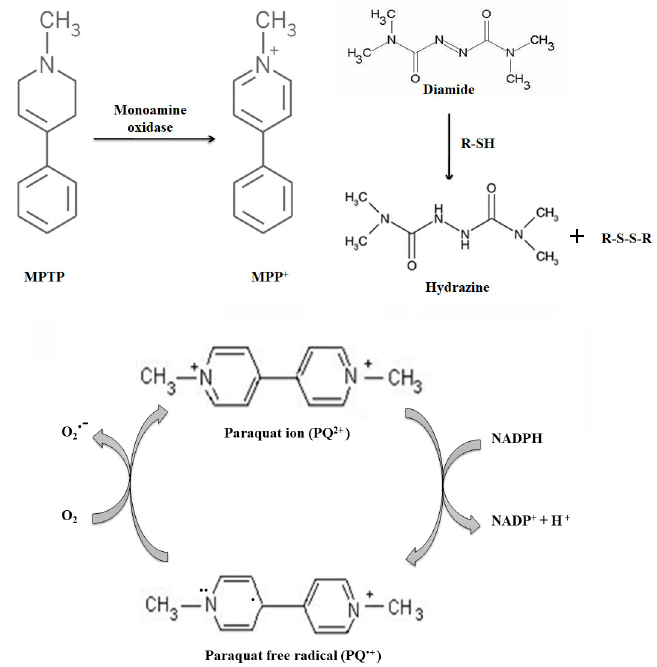
Figure 6. Neurotoxins are used to induce PD phenotype in animal models. MPP + mediates the neurotoxicity of MPTP in astrocytes and neurons. MPTP is converted into MPP + via monoamine oxidase B after crossing the blood-brain barrier. Diamide, an oxidizing agent reacts with protein thiols resulting in the formation of disulfide bond and a hydrazine derivative. Paraquat, a herbicide with a similar structure to MPP + , generates ROS by a redox cycling reaction in which the electron transfer to molecular oxygen leading to superoxide production.